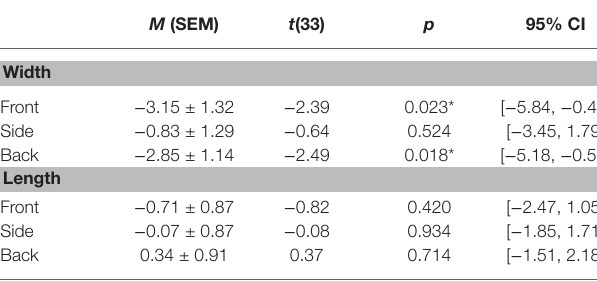
TABLE 1 | One-sample t -tests comparing mean accuracy errors (percentage distortions) to accurate (zero distortion).